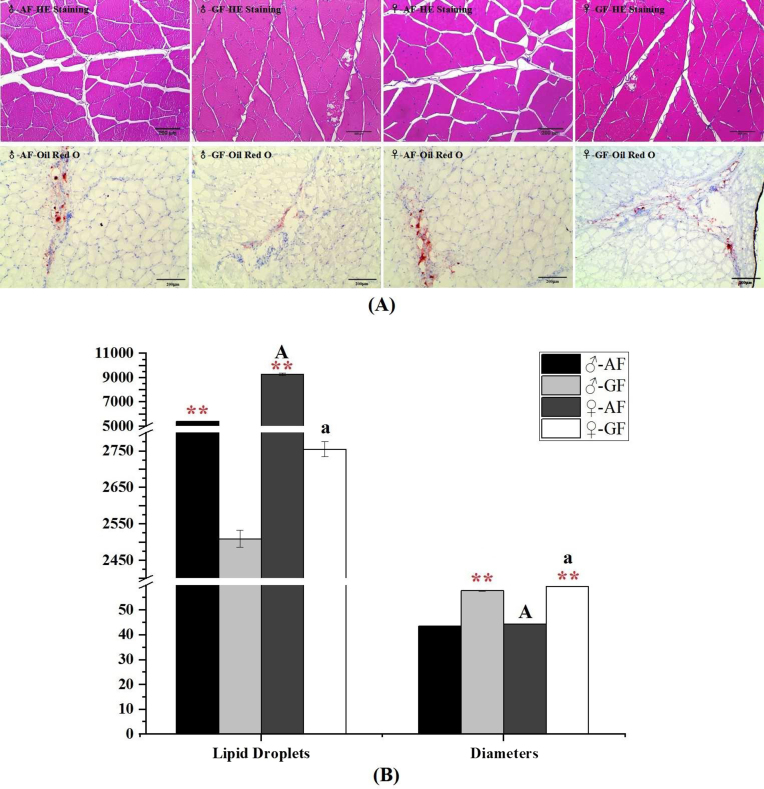
Histological sections of abdominal muscles of C. idellus. The abdominal muscle samples were collected from AF C. idellus and GF C. idellus. (A) H&E staining (original magnification ×200) shows the characteristics of abdominal muscle fibers, the oil red-O staining sections show the distributions of lipid droplets. (B) The statistical observations of muscle tissues sections (n = 50). The four different colors represent the four test groups as follows: black, ♂-AF; gray, ♂-GF; dark gray, ♀-AF; and white, ♀-GF. Vertical bars represent the mean ± standard error. The asterisks (**) indicate the significance between AF and GF under the same sex conditions. The letter “A” was used to represent the significance between two sexes of C. idellus fed with artificial feed. In addition, the letter “a” represents the significant difference between ♂-GF and ♀-GF.